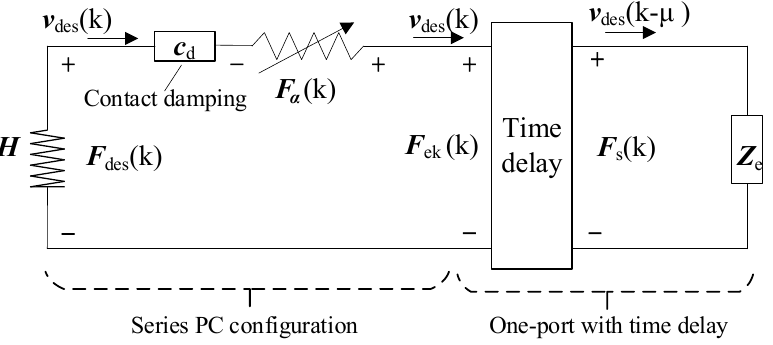
Figure 6. Passive network representing HIL simulation system. ( a ) Traditional control system view. ( b ) Network point of view.